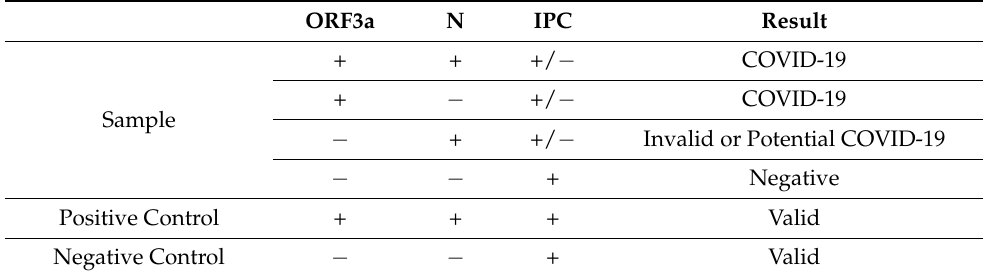
Table A1. Interpretation of real-time qPCR test for